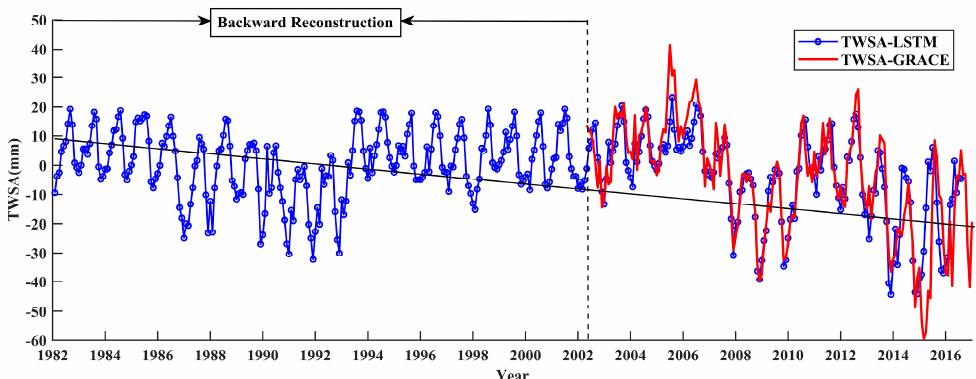
Figure 9. Comparisons between the mean monthly TWSA from GRACE and LSTM-generated TWSA.